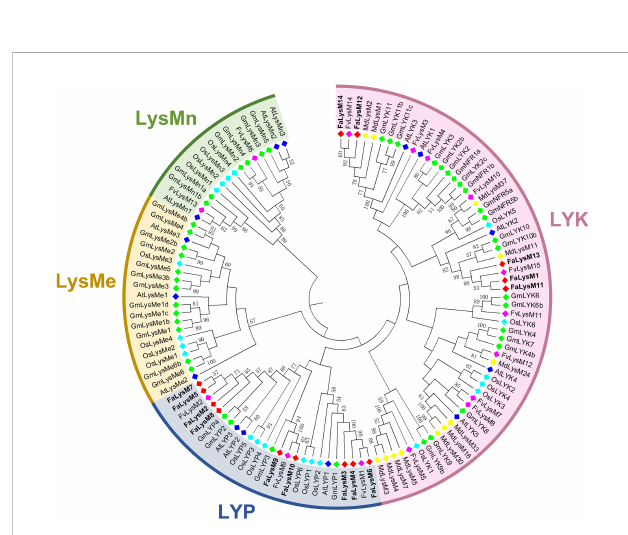
FIGURE 2 Phylogenetic relationships of LysM proteins in cultivated octoploid strawberry, wild strawberry, Arabidopsis, soybean, rice, and apple. LysM proteins from cultivated octoploid strawberry, wild strawberry, Arabidopsis, soybean, rice, and apple are labeled with the pre fi x ‘ Fa ’ , ‘ Fv ’ , ‘ At ’ , ‘ Gm ’ ‘ Os ’ and ‘ Md ’ , respectively. Different background colors indicate the different groups of the LysM proteins. The phylogenetic tree was constructed by MEGA-X with the neighbor-joining method.